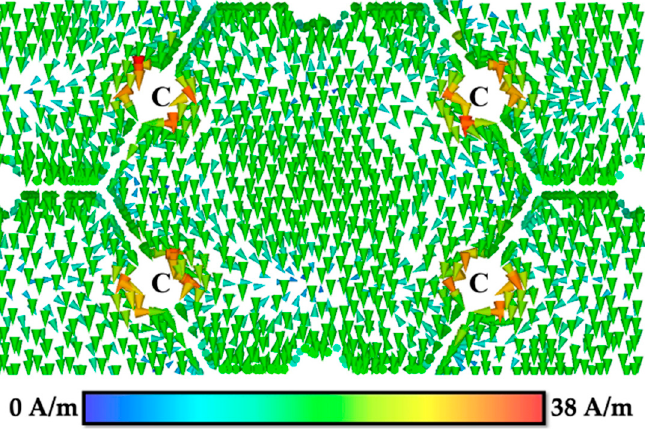
Figure 7. Surface current distribution of FSS 1 at 29.95 GHz.